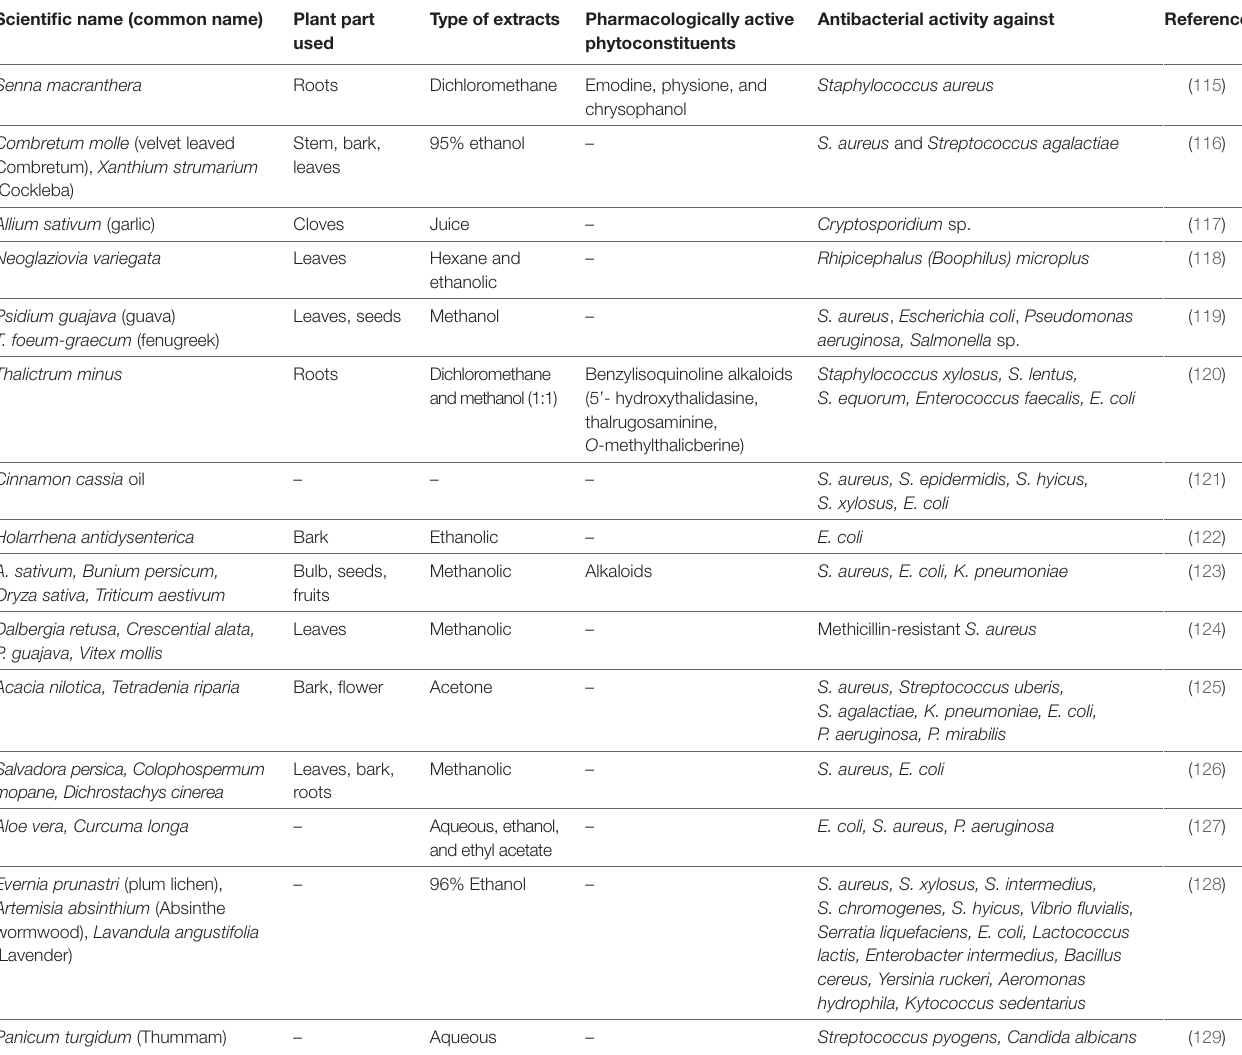
TABLe 2 | Plant extracts explored against various diseases causing bacterial pathogens in dairy animals. Scientific name (common